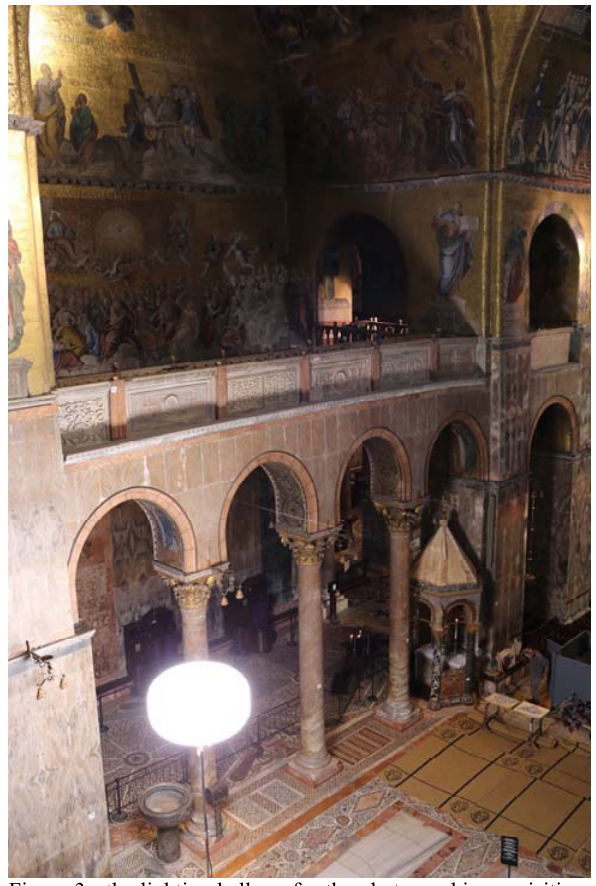
Figure 3: the lighting balloon for the photographic acquisition.